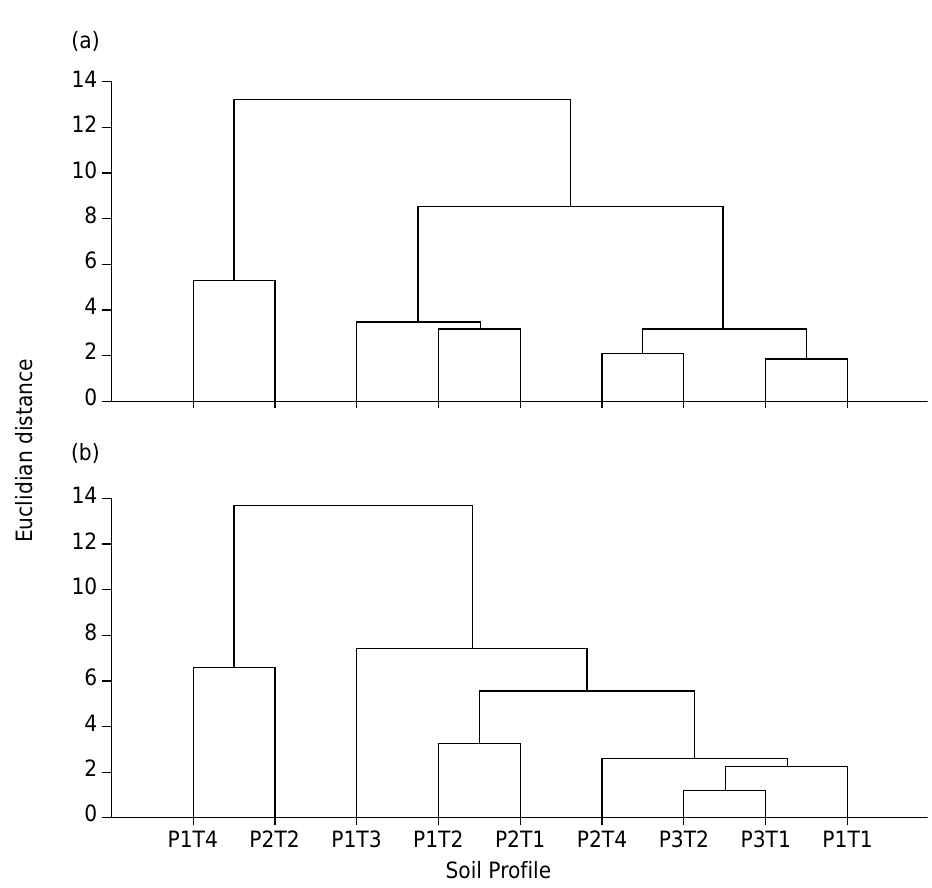
Figure 3. Agglomerative hierarchical grouping between the horizons of the soil profiles by the method of dissimilarity by Euclidean distance: (a) dendrogram by the properties of the A horizon; (b) dendrogram by the properties of the B horizon.